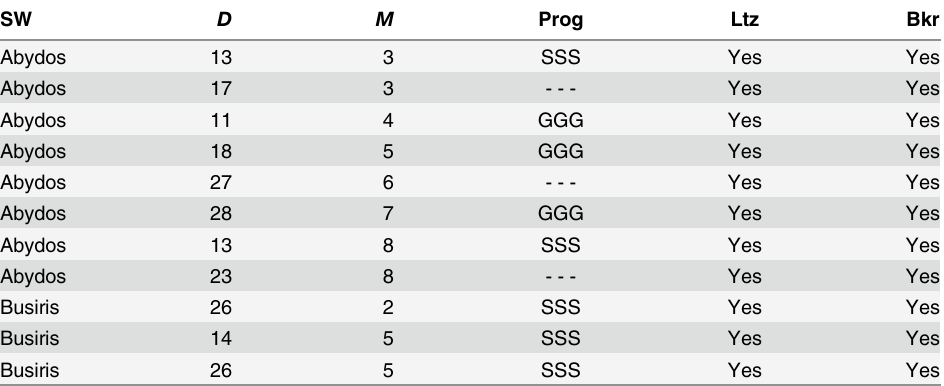
Table 2. SWs identified in